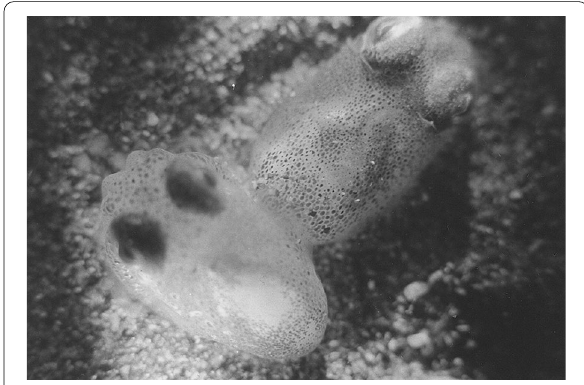
Fig. 2 Pair of Sepietta obscura resting after mating (female to the right) (photo © Adrianne